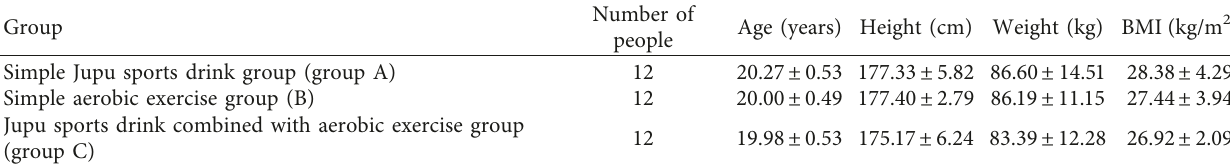
Table 1: Basic information of each group in the